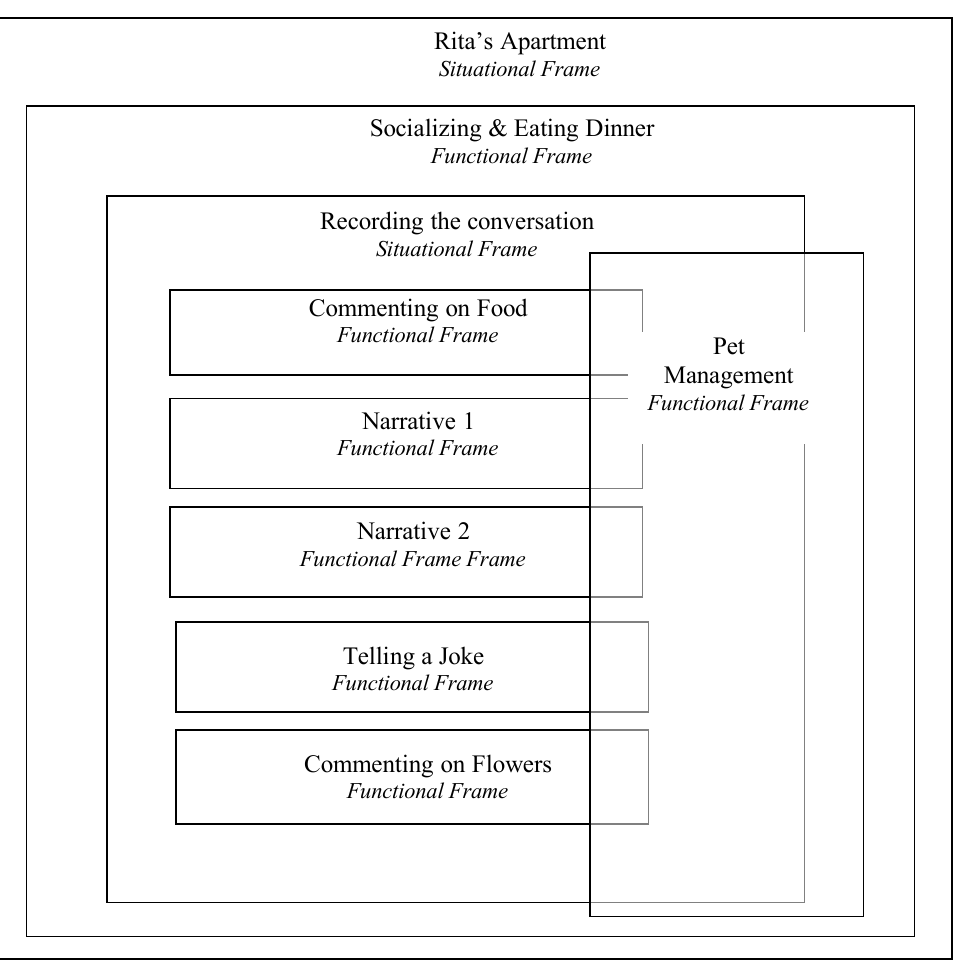
Layered Frames 1 : Martin & Rita’s